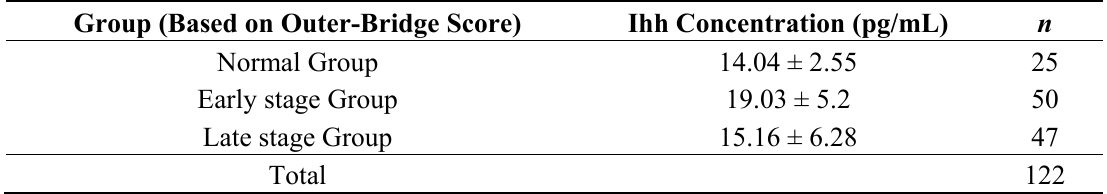
n , number; Normal group, articular cartilage Outer-bridge score = 0; Early stage group, articular cartilage Outer-bridge score = 1–2; Late stage group, articular cartilage Outer-bridge score =